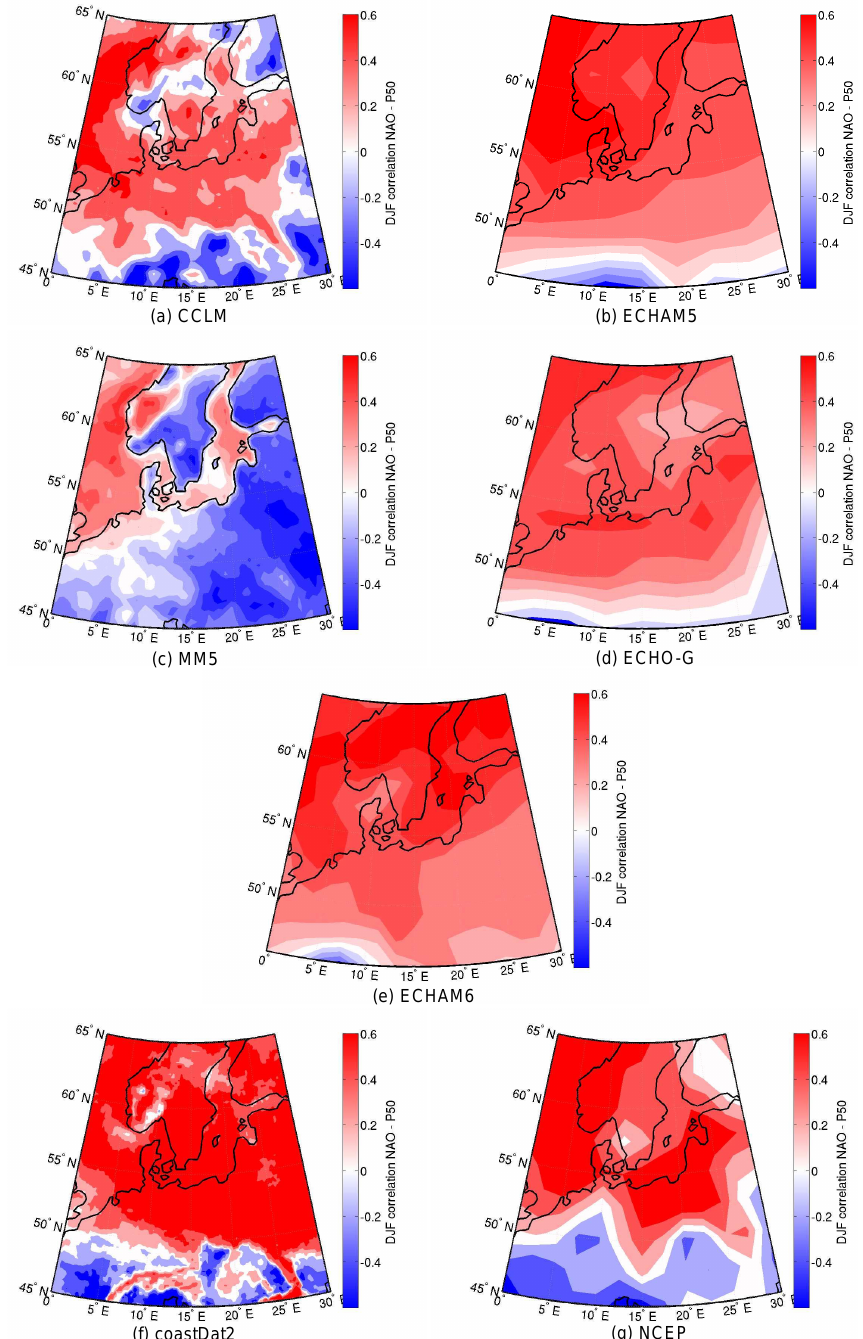
Figure 5. Correlation between NAO index and 50th percentile of wind speed for seven different data sets: (a) CCLM (1655–1999 AD), (b) ECHAM5 (850–2005 AD), (c) MM5 (1001–1990 AD), (d) ECHO-G (1001–1990 AD), (e) ECHAM6 (850–2005 AD), (f) coastDat2 (1948–2012 AD), (g) NCEP (1948–2012 AD).